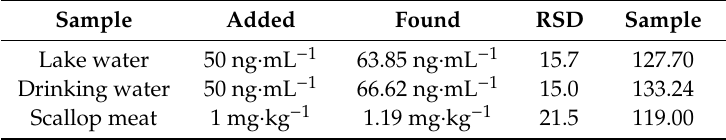
Table 2. Determination of As(III) in water samples and food sample.